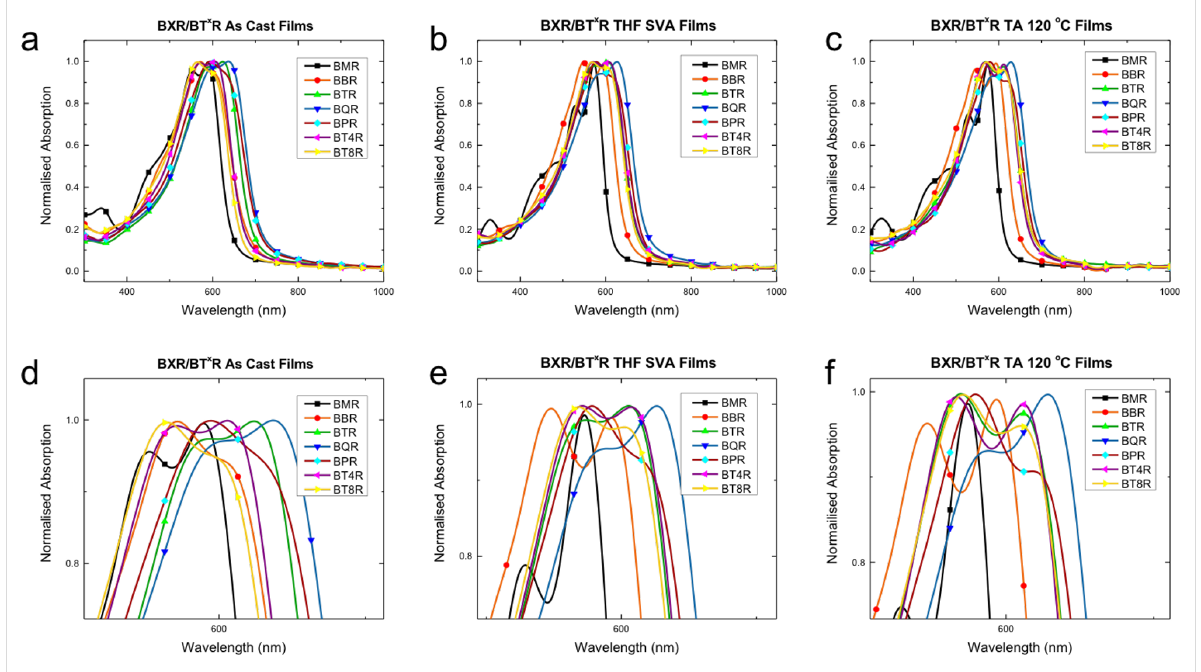
Figure 5: Normalised thin film UV–vis absorption profiles for the BX x R series for, a) as-cast films (from CDCl 3 ), b) after solvent vapor annealing (SVA with THF for 10 seconds, and c) thermally annealed (TA) at 120 °C for 10 minutes. Expansions of the peak areas in a), b), and c) are shown in d), e), and f).